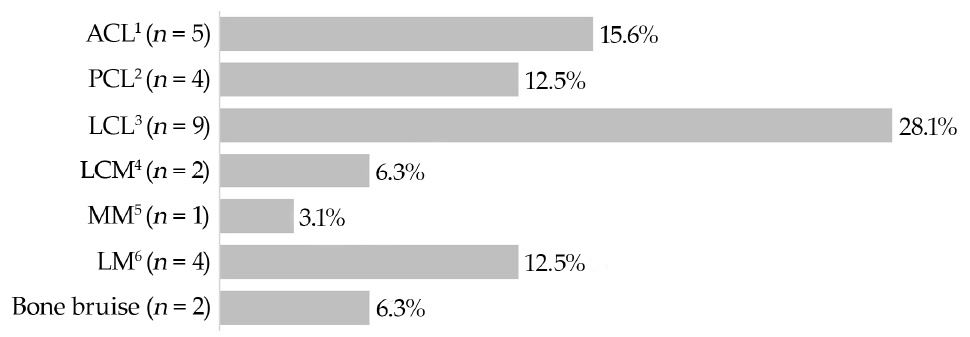
Figure 5. Concomitant injuries related to 33 patients via MRI after acute QTR. 1 Anterior cruciate ligament, 2 posterior cruciate ligament, 3 lateral collateral ligament, 4 medial collateral ligament, 5 medial meniscus and 6 lateral meniscus.